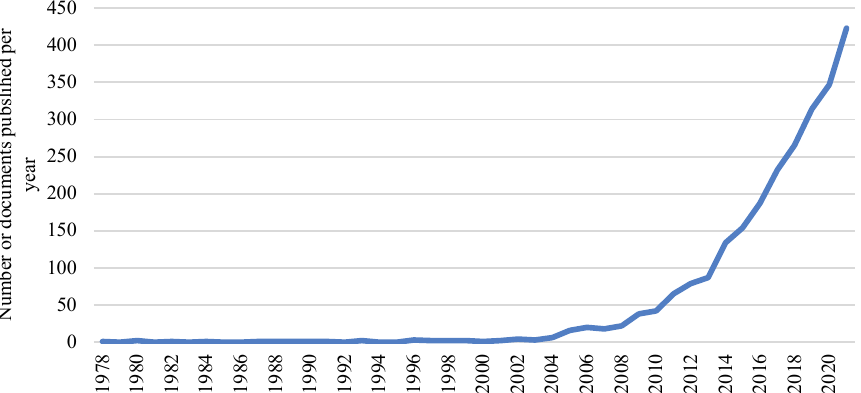
Fig. 1. Number of documents published in Scopus per year on topic of biobased